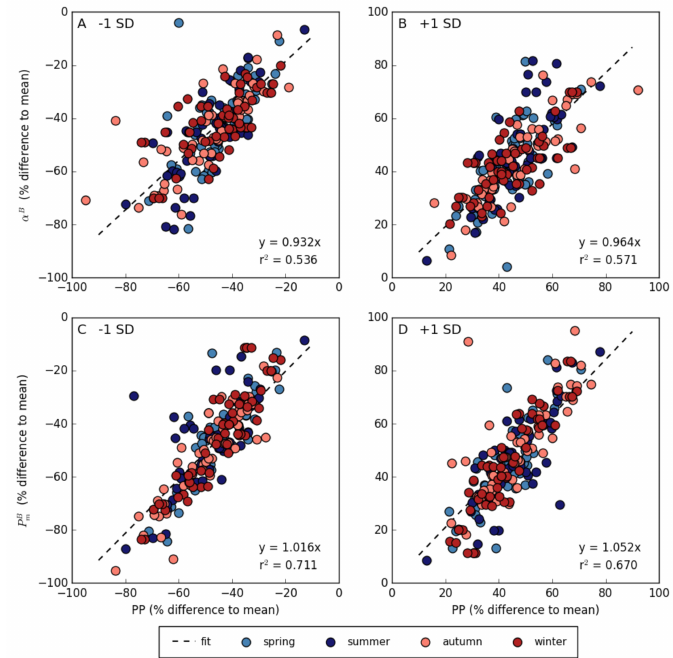
Figure 4. Relationship between photosynthesis versus irradiance (P-I) parameters and primary production (PP) expressed as percentage difference in ( A , B ) the initial slope ( α B ) and ( C , D ) the assimilation number ( P B m ) of the P-I curve and primary production for –1 standard deviation (–1 SD) ( A , C ) and +1 standard deviation (+1 SD) ( B , D ) compared with mean P-I parameters estimates. Each point represents a biogeographical province and season for the period between 1998 and 2018.